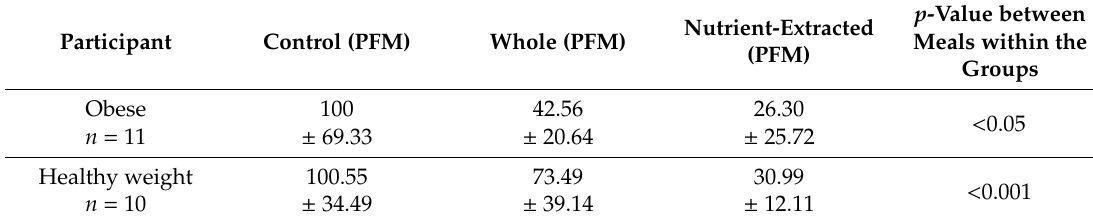
Table 2. Mean glycemic index ± standard deviation for raspberry-mango (RM). 63 Table 3. Mean glycemic index ± standard deviation for passionfruit-mango